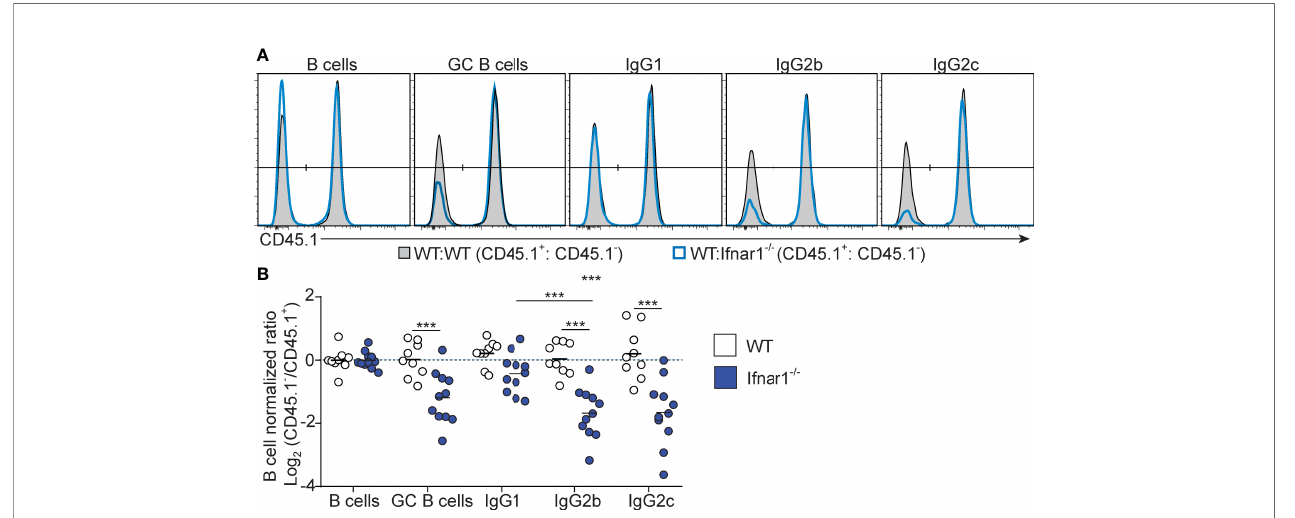
FIGURE 5 | B cell intrinsic type I IFN signaling selectively ampli fi es the magnitude of IgG2 + GC B cell responses. Mixed BM chimeras were generated by reconstituting WT recipients with a 1:1 mix of CD45.1 + CD45.2 + WT and CD45.1 - CD45.2 + WT or Ifnar1 -/- BM cells. Eight - 10 weeks after reconstitution, chimeras were immunized with OVA/poly I:C and the proportion of CD45.1 + versus CD45.1 - cells among total splenic B cells and within indicated GC B cell population determined by fl ow cytometry 8 dpi. (A) Representative results for control (WT : WT) and experimental (WT : Ifnar1 -/- ) BM chimeras. (B) Pooled results of log 2 normalized CD45.1 - to CD45.1 + cell ratio in individual control and experimental chimeric animals. Results are from three individual experiments. Each symbol represents one mouse. *p ≤ 0.05, **p<0.01 and